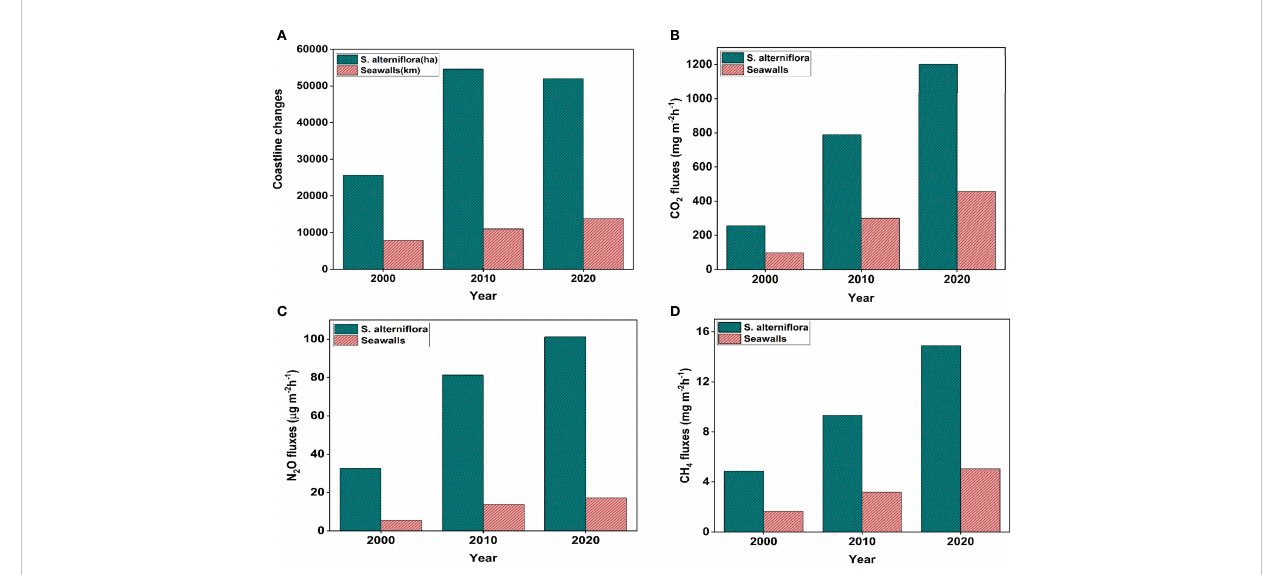
Table 1 keyword combinations utilized in the original bibliography for this synthesis. For each key combination, the database was retrieved using the search terms: (China), (coastal wetland OR seagrass meadows OR intertidal fl ats OR tidal saltmarshes OR mangrove forests OR tidal freshwater), (Spartina alterni fl ora OR invader* OR invasive* OR invasion* OR exotic